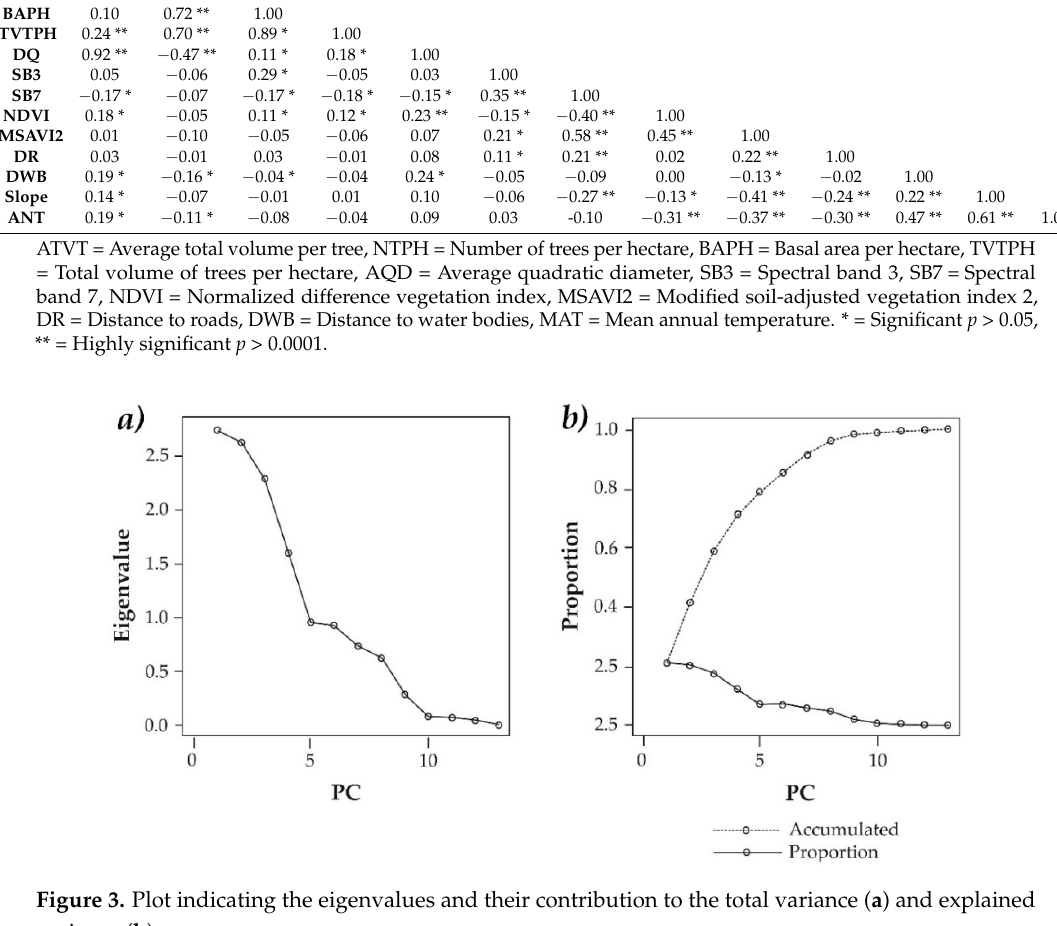
Table 2. Matrix of different variable correlations considered in the analysis.